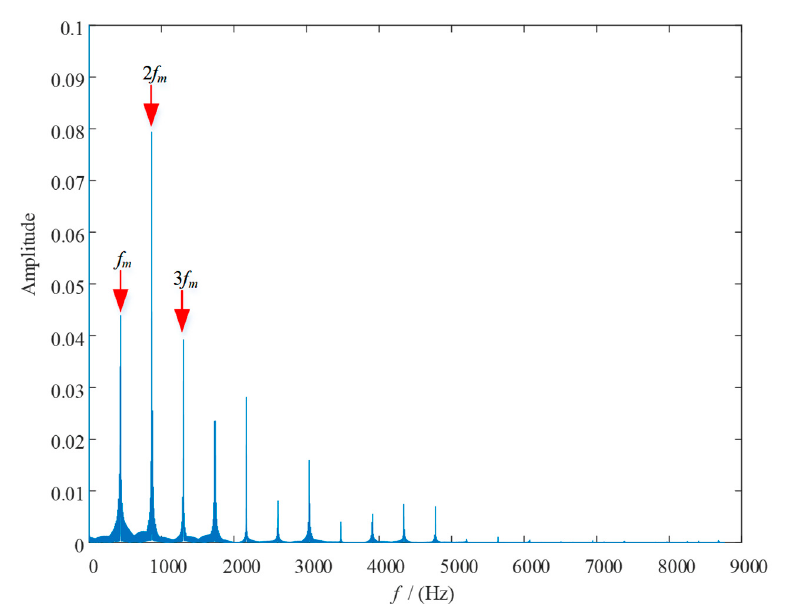
Figure 14. Simulation signal in crack condition.